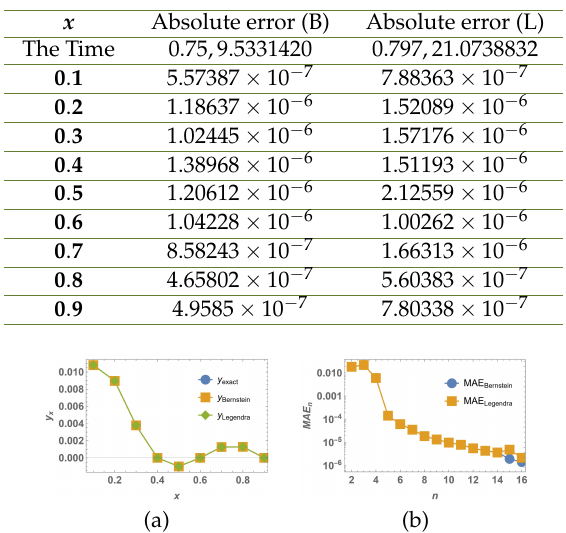
Fig. 1. a) Comparison exact solution and approximate solution of (BOM, LOM) methods at n=1; b) Logarithmic plots for the MAE n of example 1 form n=2 to